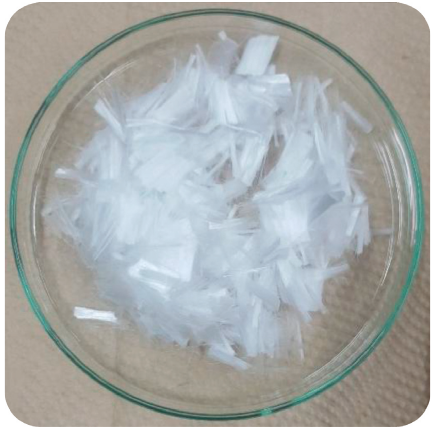
Figure 4: Polypropylene